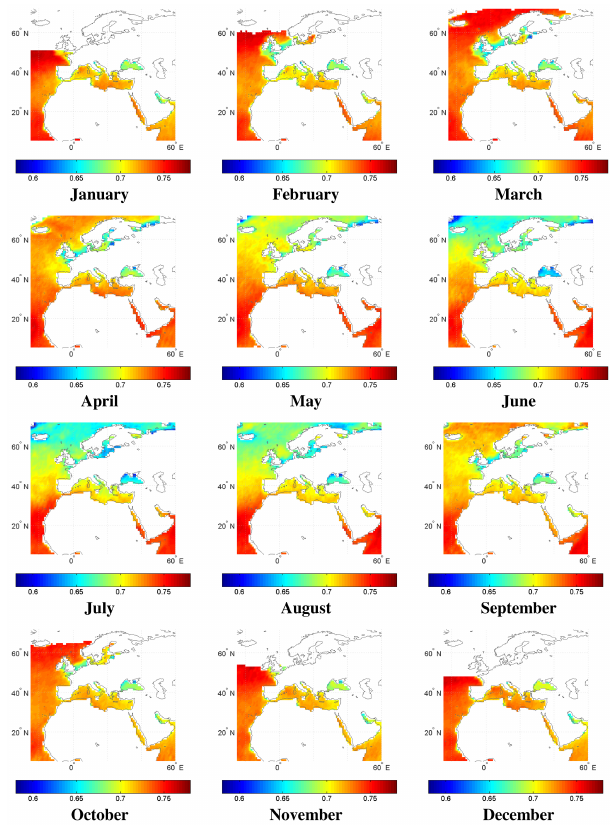
Figure 3. Month by month variation of MODIS-Aqua g aer values at 470nm averaged over the period